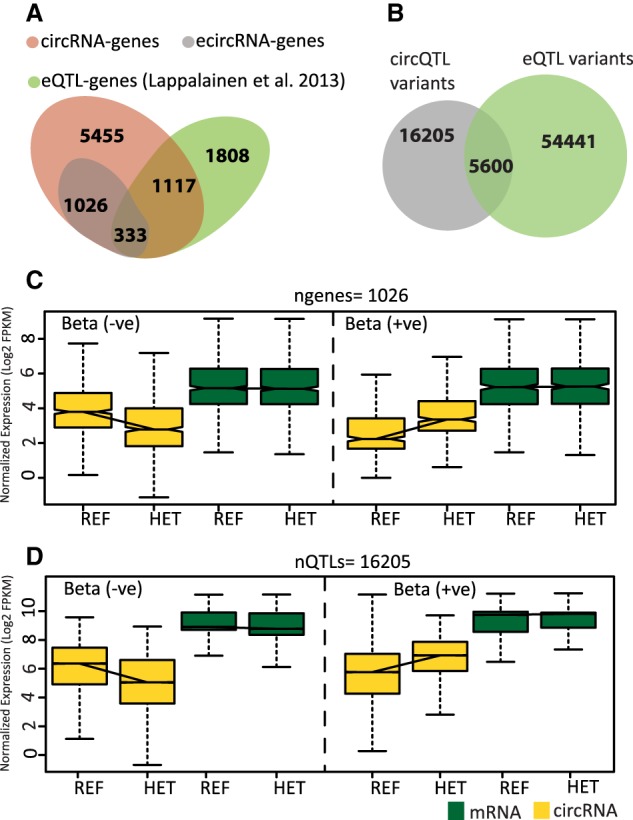
Comparison of circQTL and eQTL variants and their effects on gene expression. (A) Venn diagram showing an overlap of ecircRNA genes with eQTL genes from Lappalainen et al. (2013). (B) Venn diagram showing distribution of genomic variants associated with circRNA and mRNA expression in 333 genes that contain both circQTL and eQTL SNPs. Only ∼7% (5600) of QTLs are shared and show association with both circRNA and mRNA expression in these genes. (C) Boxplots representing distribution of average expression from all individuals with a given genotype. The trends in circRNA and mRNA expression between reference homozygous and heterozygous genotypes for best circQTL SNP, in 1026 ecircRNA genes that do not contain any eQTL associations. (D) circRNA and mRNA expression trends for 16205 circQTL SNPs from genes having both circQTL and eQTL markers.